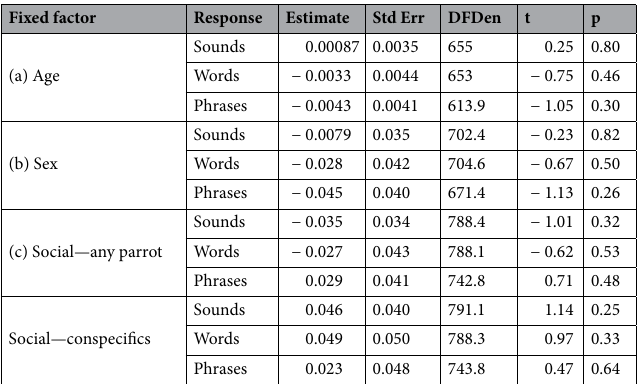
Table 2. Output of Linear Mixed Models testing for parrot vocal mimicry repertoire variation associated with (a) age, (b) sex, and/or (c) social interactions with other parrots.